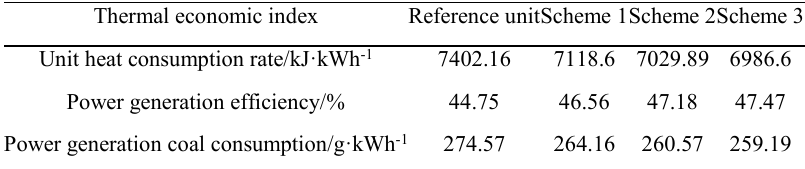
Table 2. Performance comparison of secondary reheat units.